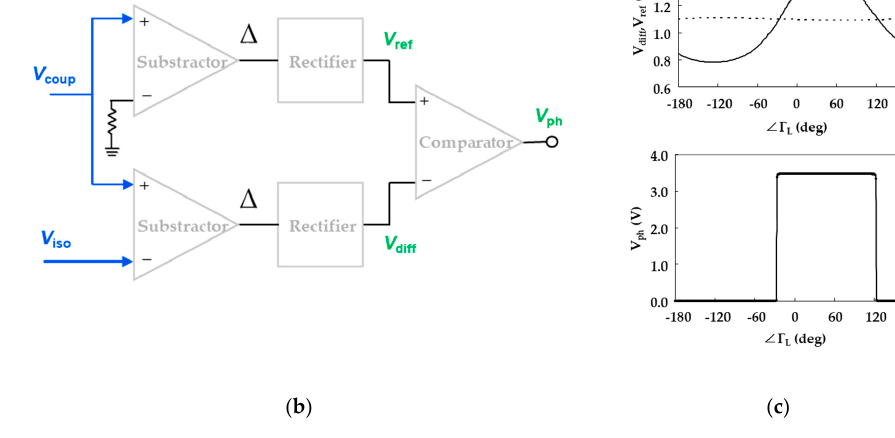
( b ) Figure 5. Example of defining impedance sections: ( a ) Simulation result of V ph ; ( b ) resultant impedance sections. (Assuming that │ Γ L │ is determined by voltage standing wave ratio (VSWR, │ Γ L │ ) detector). Table 1. Example of detecting section from V ph value set. (Figure 5a). Index V ph (1 st ) V ph (2 nd ) Detected Section 1 1